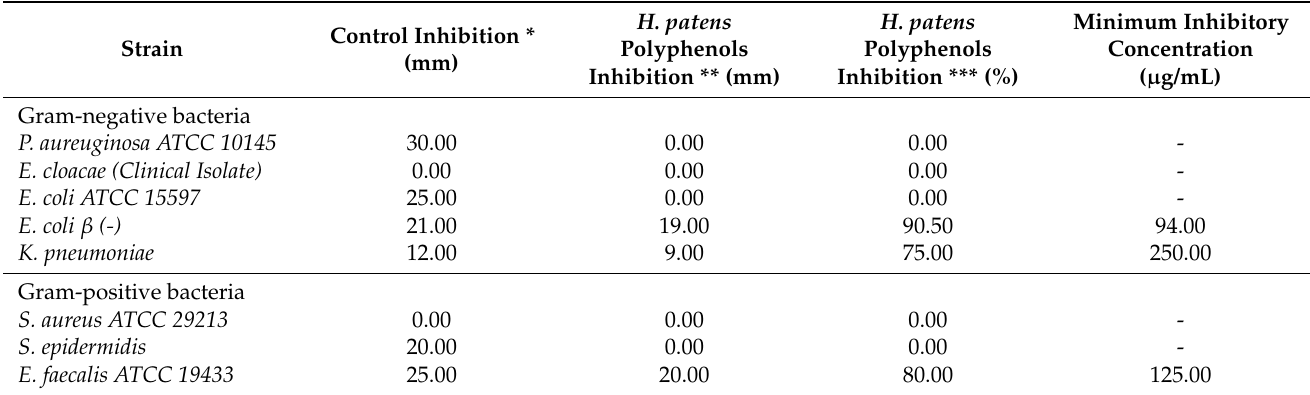
Table 5. Inhibitory effect of purified polyphenol fraction of H. patens against Gram-negative and Gram-positive bacteria.